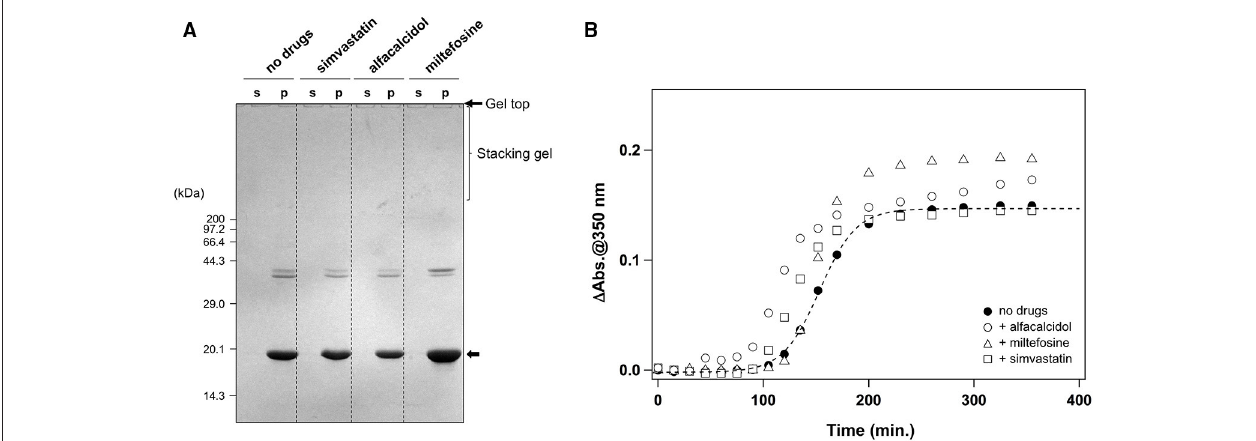
FIGURE 5 | Specificity of the hit compounds for the inhibition of apo-SOD1(G37R) S-S oligomerization. (A) 20 µ M apo-SOD1(G37R) SH in the NNE buffer with 5mM DTT was shaken at 1200rpm at 37 ◦ C in the presence or absence of the indicated drugs (20 µ g/mL). After 24h of agitation, the samples were fractionated to soluble supernatant (s) and insoluble pellets (p) by ultracentrifugation and then analyzed by non-reducing SDS-PAGE using a 12.5% polyacrylamide gel. (B) Effects of the drugs (20 µ g/mL) on the aggregation kinetics of 20 µ M HTT EX1 (42Q) were monitored by solution turbidity (absorbance at 350nm): no drugs (filled circles), alfacalcidol (open circles), miltefosine (open triangles), and simvastatin (open